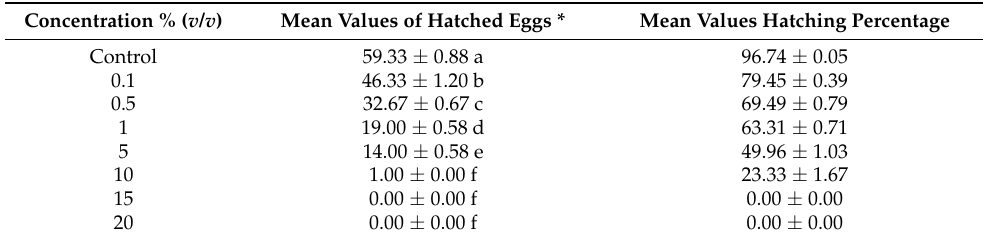
Table 5. Mean values ( ± SE) of hatched eggs laid by Tetranychus merganser females during the first 24 h.